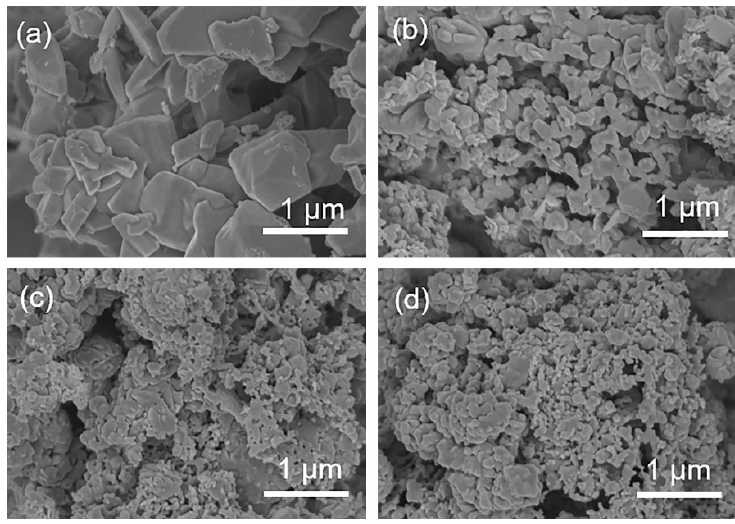
Figure 3. SEM images of ( a ) MC, ( b ) MC-Ni-1, ( c ) MC-Ni-1.5 and ( d )